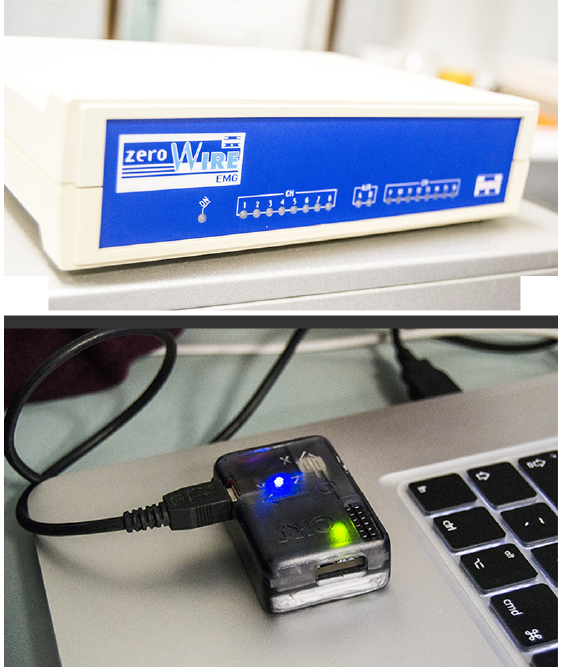
Figure 1. Measurement equipment: sEMG system and